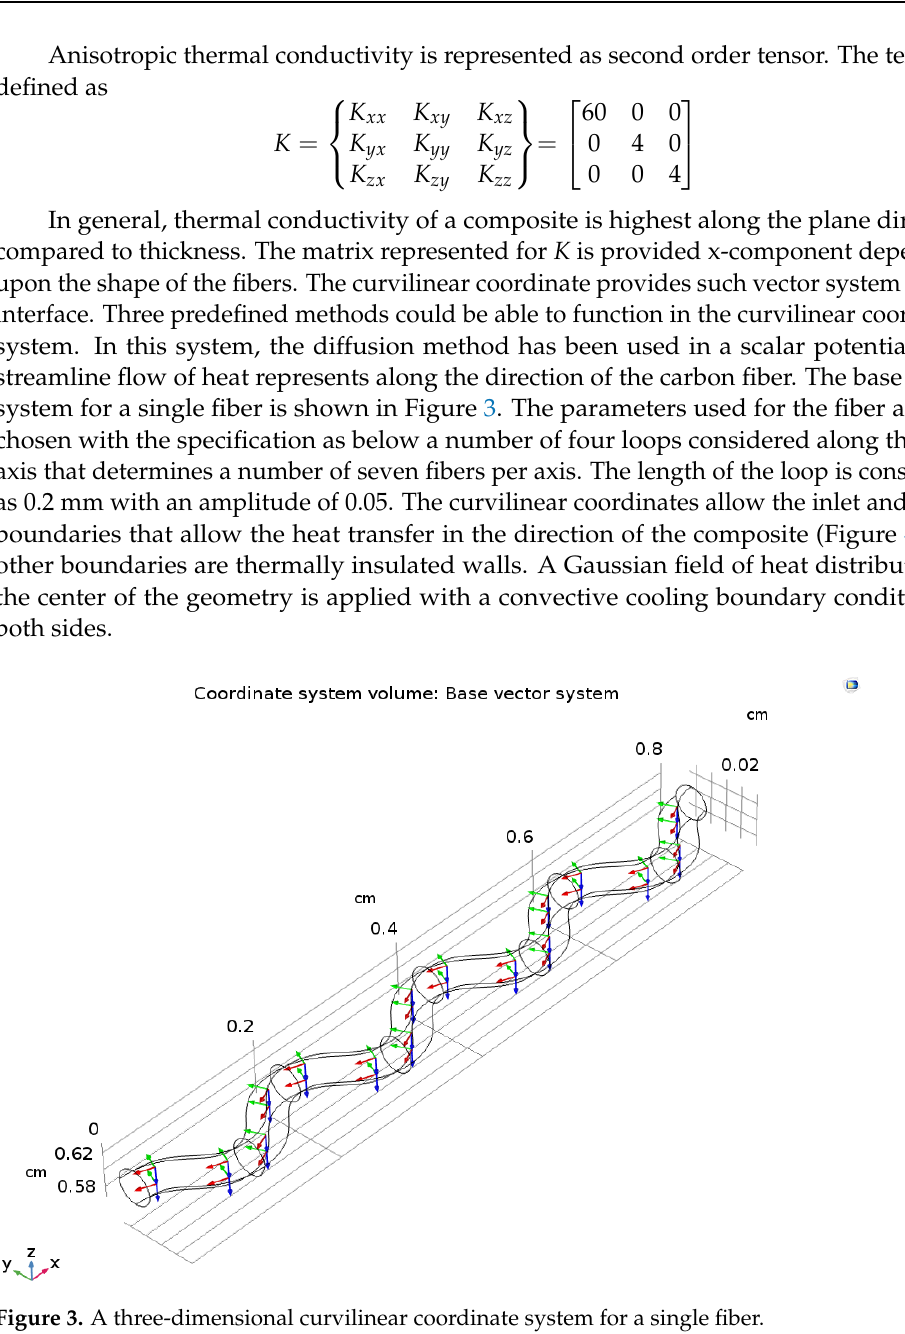
Figure 4. Fiber streamline flow in the composite system. 2.2. Carbon Fiber Reinforced Geopolymer Composite The composites were prepared by manually stacking 10 layers of carbon fiber im- pregnated with the geopolymer matrix. The fabrication steps are shown in a schematic diagram in Figure 5.